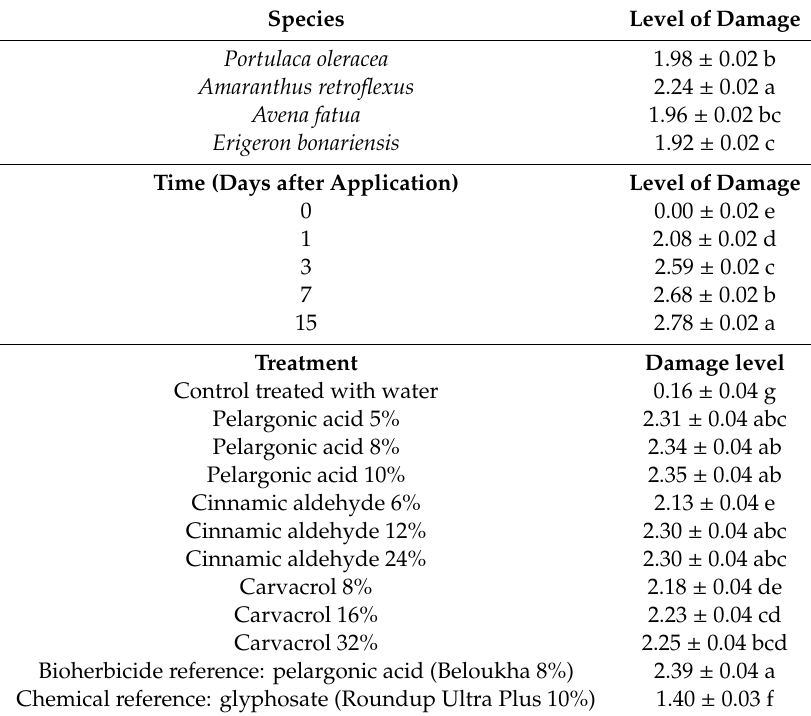
Table 6. Damage level depending on the species, time after application, and